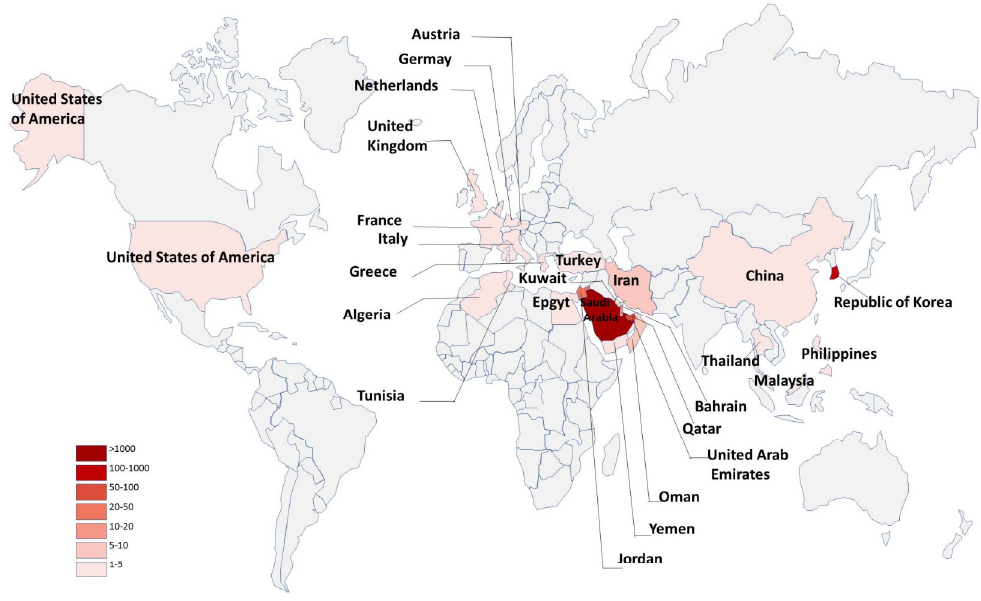
Figure 1. Summary of morbidity statistics with country- and quarter-level panel